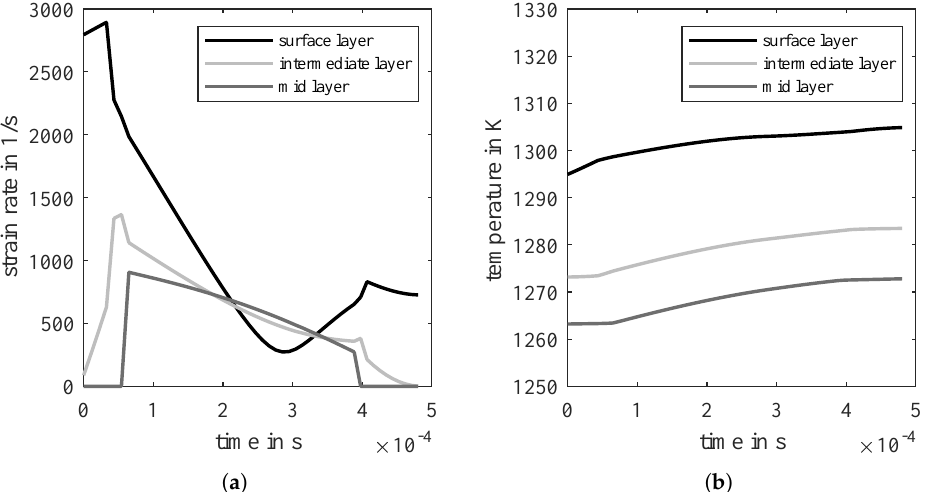
Figure 2. ( a ) equivalent strain rate and ( b ) temperature of surface, intermediate, and mid-layer of the hot strip in the last hot rolling